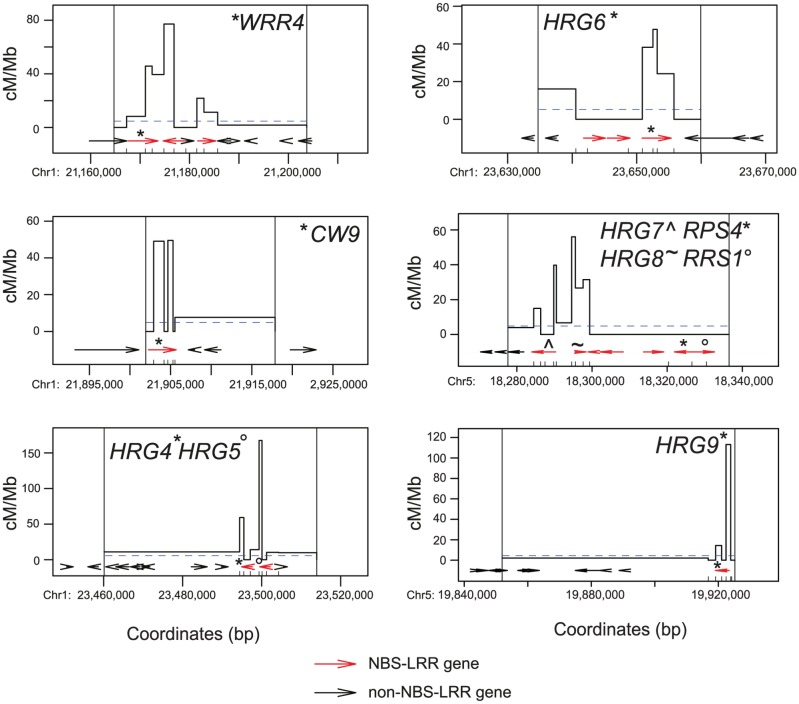
Fine-mapping MRC NBS-LRR gene crossover hotspots.Crossover frequency (cM/Mb) in high recombination MRC intervals containing NBS-LRR genes (S6–S11 Tables). Internal dCAPs marker positions are indicated by x-axis ticks, in addition to whether the region is located in MRC1 (Chr1) or MRC5 (Chr5). NBS-LRR genes are indicated by red arrows and non-NBS-LRR genes by black arrows. The chromosome average recombination rate for Col×Ler male backcrosses is indicated by horizontal, dotted blue lines [71]. Vertical black lines indicate the location of SNP markers genotyped in MRC maps (S2 and S3 Tables). NBS-LRR domain gene names are printed within the plot and symbols used to indicate which gene arrows they correspond to.